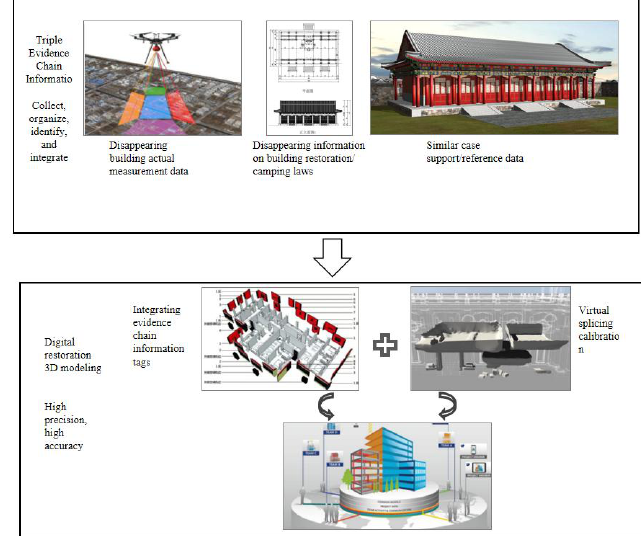
Figure1. Triple Evidence